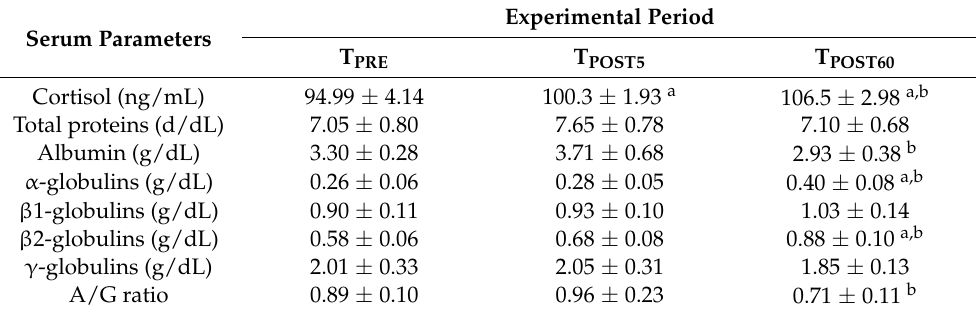
Note: statistical significances: a versus T PRE ( p < 0.01); b versus T POST5 ( p <